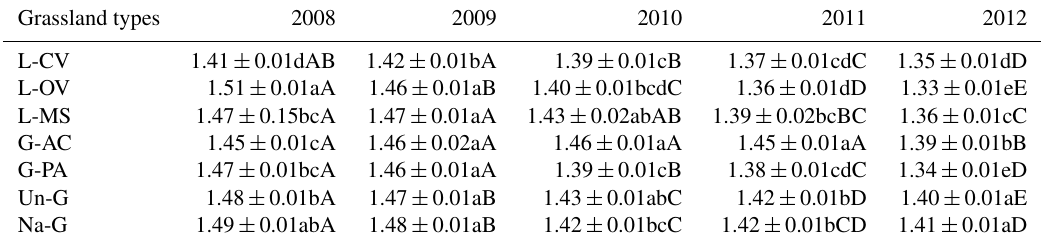
Table 5. Soil bulk density (M ± SEgcm − 3 , average value of 100cm soil depth) in different years and grassland types. The grassland types are L-CV, Coronilla varia ; L-OV, Onobrychis viciifolia ; L-MS, Medicago sativa ; G-PA, Poa pratensis ; G-AC, Agropyron cristatum ; Un-G, uncultivated grassland; Na-G, natural grassland. Values followed by different lowercase letters within columns and uppercase letters within rows are significantly different at p